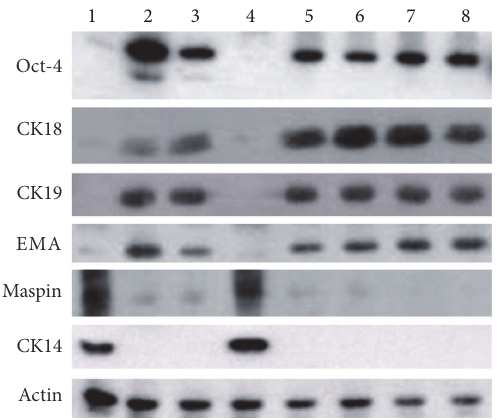
Figure 5: Western blot analysis of Oct-4, CK18, CK19, EMA, maspin, and CK14 expression in HBECs. Lane 1: Type II HBEC30 developedintheMSU-1medium; Lane2: TypeIHBEC30developed in the MSU-1 medium; Lane 3: Type I HBEC30 developed in the K-NAC medium (cpdl = 27); Lane 4: Type II HBEC31 developed in the MSU-1 medium; Lane 5: Type I HBEC31 developed in the MSU-1 medium; Lane 6: Type I HBEC31 developed in the K-NAC medium (cpdl = 18); Lane 7: Type I HBEC31 developed in the K- NAC medium (cpdl = 24); Lane 8: Type I HBEC31 developed in the K-NAC medium (cpdl = 29).